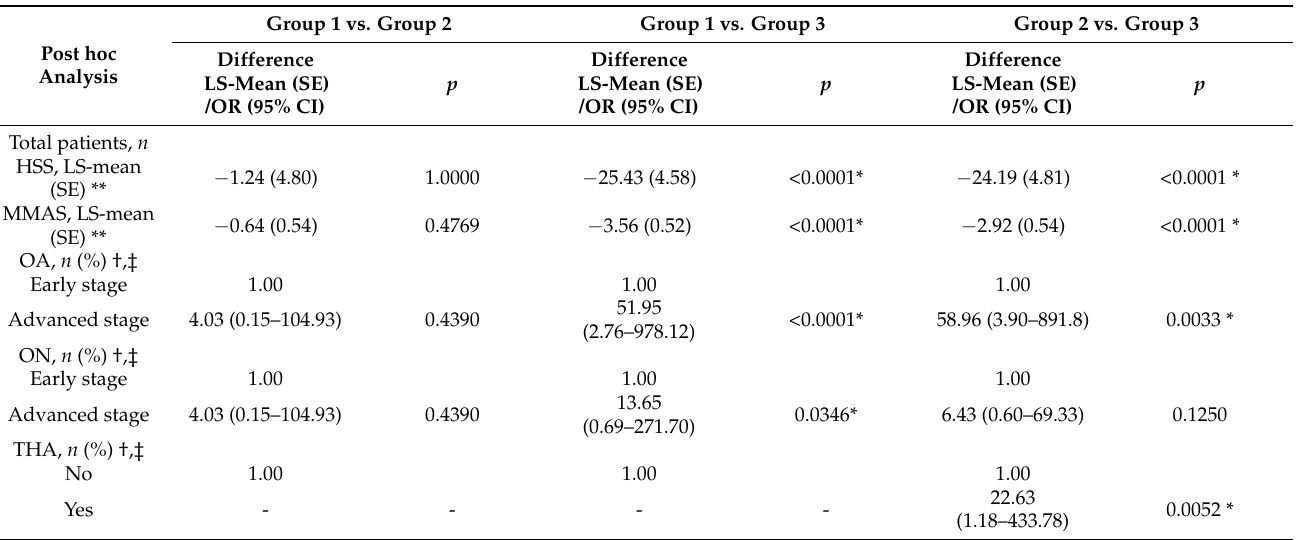
Table 5. Post hoc comparisons for the effects of different status of comminution on clinical and radiographic outcomes in patients with